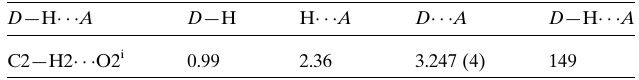
Table 1 Hydrogen-bond geometry (A˚ , (cid:3) ).